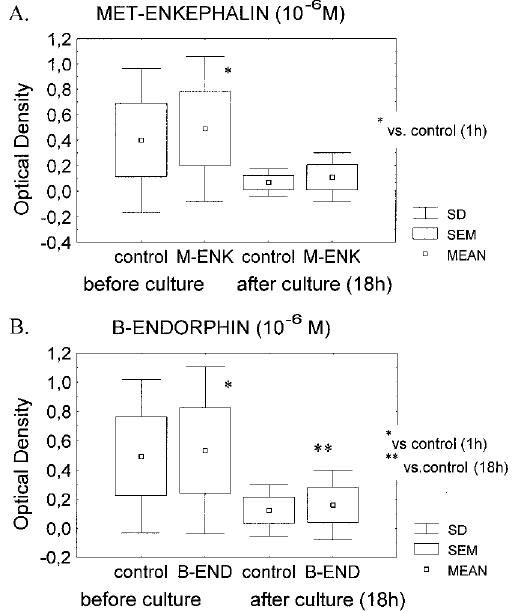
FIG. 2. A representative experiment of MTT reduction by neutrophils treated with 10 –6 M of opioid peptides before and after culturing in vitro . The potency of PMN to produce ROS as their ability to reduce the tetrazolium salt MTT to formazan was measured as described in Materials and methods. Briefly, neutrophils (2 ´ 10 5 /well) were placed in 96-well plates in 150 m l of RPMI 1640 with 10% of FCS and M-ENK and/or b -END (10 –6 M). Then, 50 m l of MTT solution in PBS (1mg/ml) was added to each well. In experiments with cultured neutrophils at the end of the culture period, the